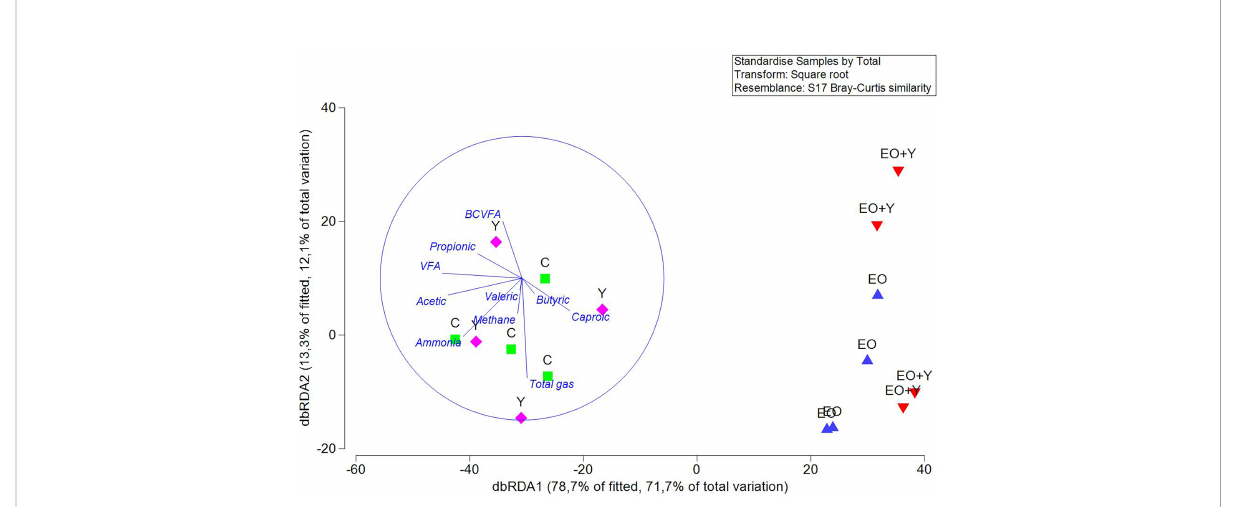
FIGURE 2 DbRDA illustrating the relationship between the structure of the archaeal community with the rumen fermentation pattern in the RUSITEC system. Arrows show the direction of the gradient. Samples belonging to each treatment are represented by blue and red triangles, essential oil alone or combined with yeast, respectively, green square for samples of the control treatment, and pink rhombus for those of the yeast treatment.